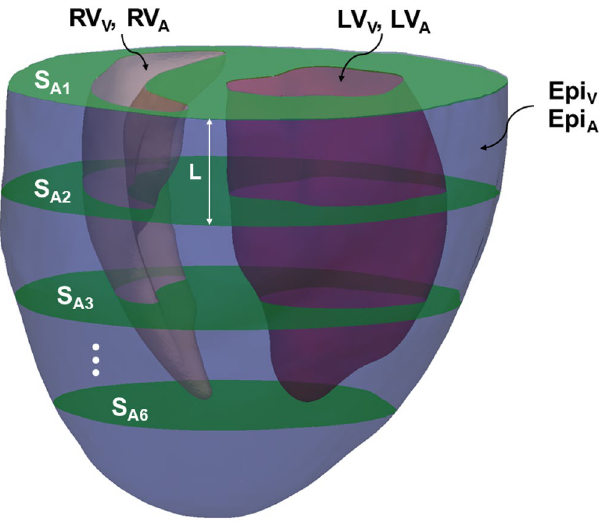
Figure 4. Geometric features: Volume and endocardial area of the LV ( LV V and LV A ), volume and endocardial area of the RV ( RV V and RV A ), interior volume and area of the epicardial surface ( Epi V and Epi A ), and the area of six, equally-spaced, short-axis slices ( S A 1 , S A 2 , ..., S A 6